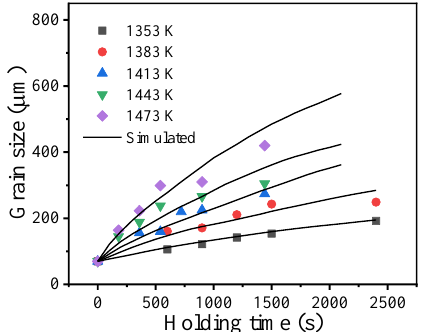
Figure 9. Comparisons between measured and simulated grain sizes.